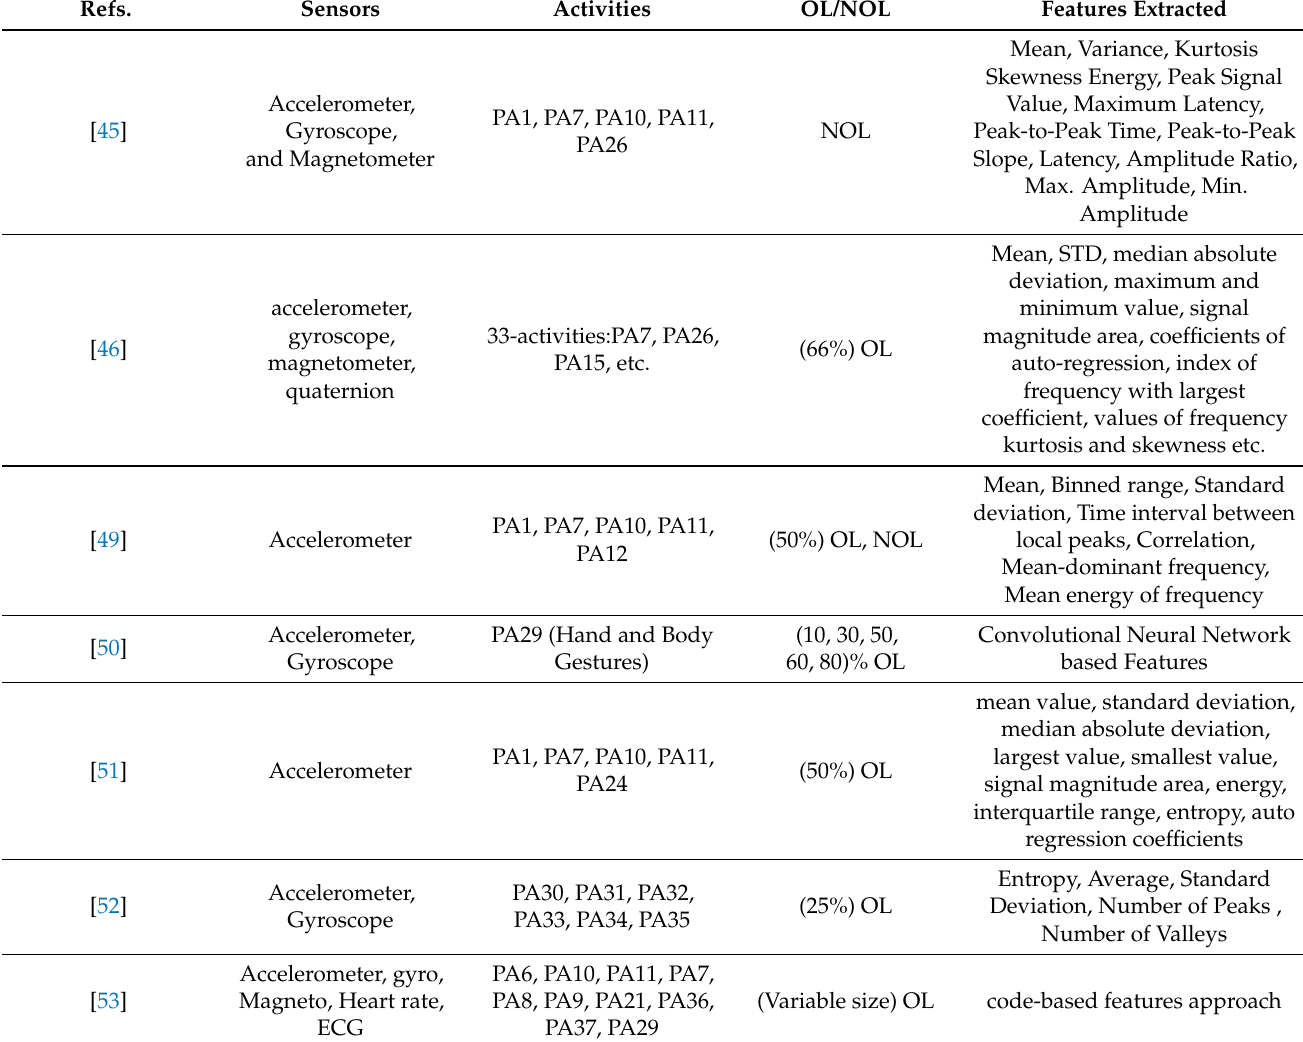
Table 2. Literature summary of sensors, physical activities, features extraction based on overlapping and non-overlapping, and selected features for HPAR.